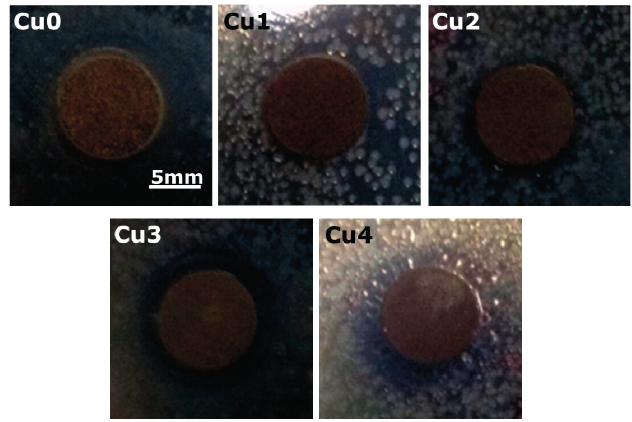
Figure 11. Antibacterial experiment of E. coli on the Cu0, Cu1, Cu2, Cu3 and Cu4 surfaces after 24 h of